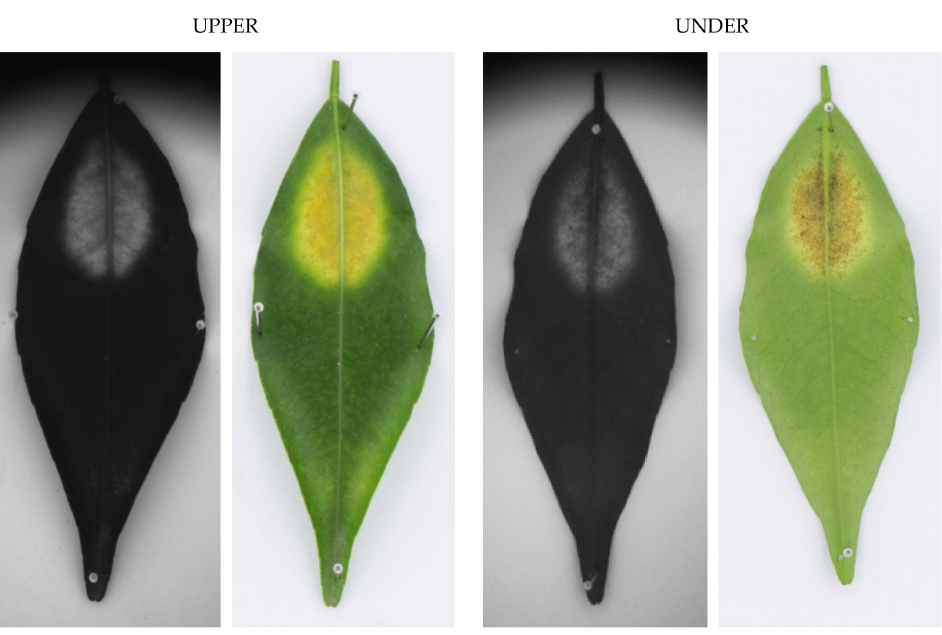
Figure 2. Images captured at 650 nm and colour of the two sides of a leaf affected by T. urticae .